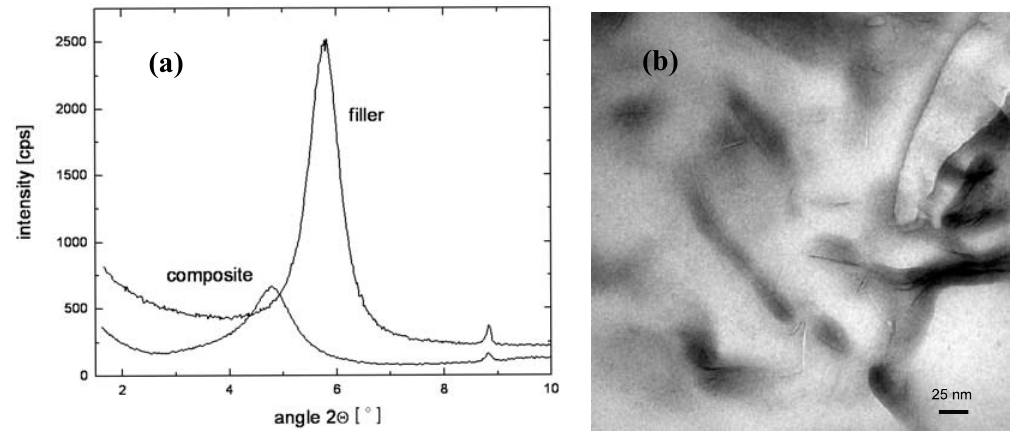
Figure 9. (a) X-ray diffractograms of benzyldibutyl(2-hydroxyethyl)ammonium modified montmorillonite and its nanocomposites with epoxy polymer containing 3 vol% filler and (b) TEM micrograph of the epoxy nanocomposite. Reproduced from reference